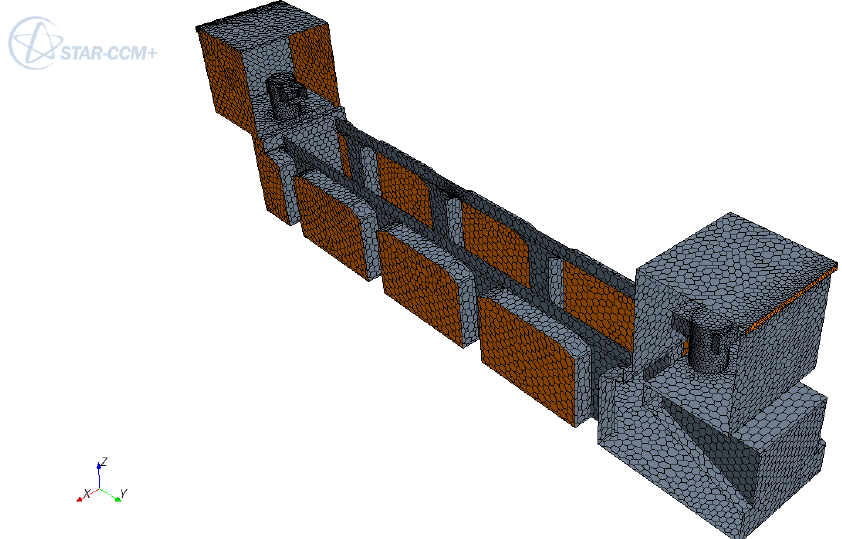
Figure 3. Computational fluid dynamics (CFD) model: polyhedral meshing of the geometry (battery